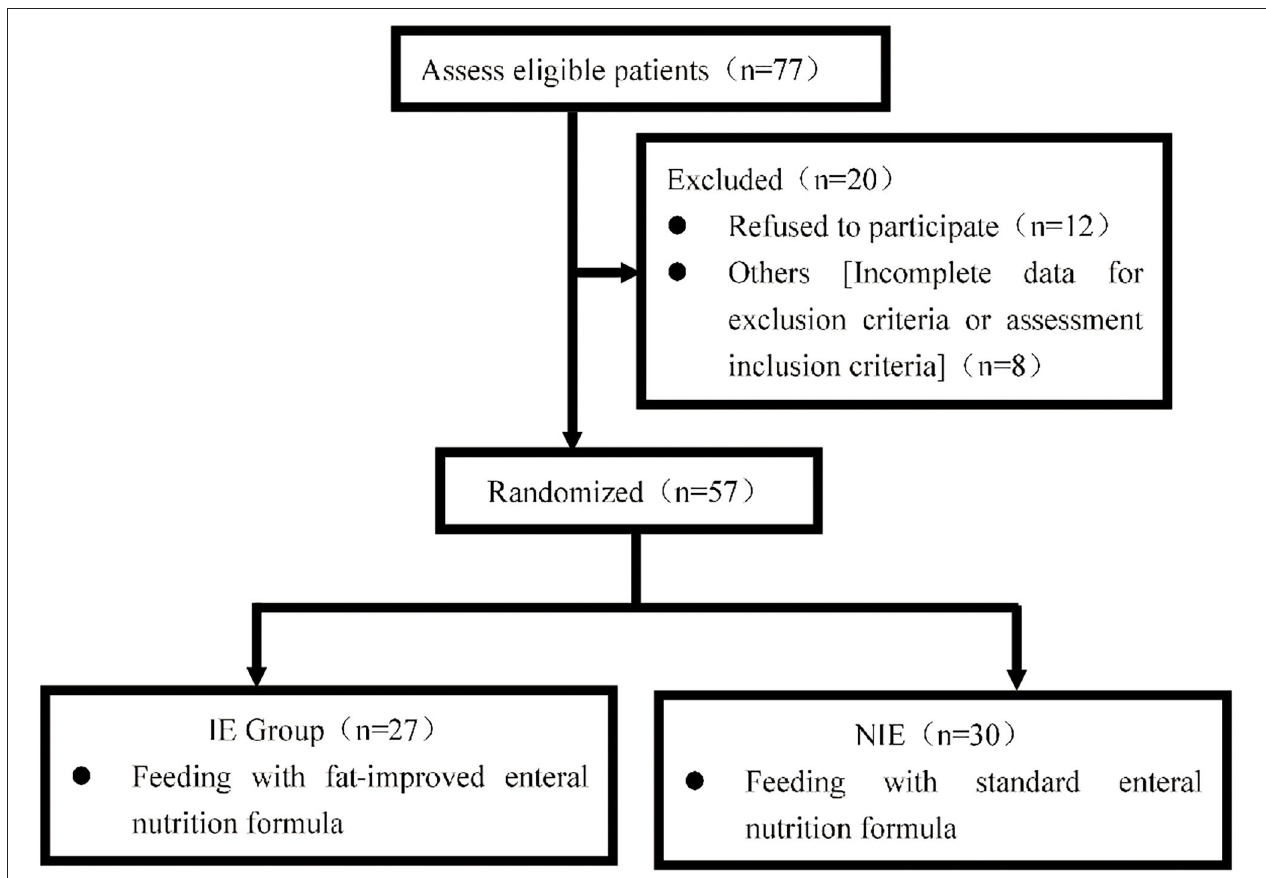
FIGURE 1 | Patients were approached and recruited according to the inclusion and exclusion criteria. 419 NIE, non-immune-enhancing; IE,